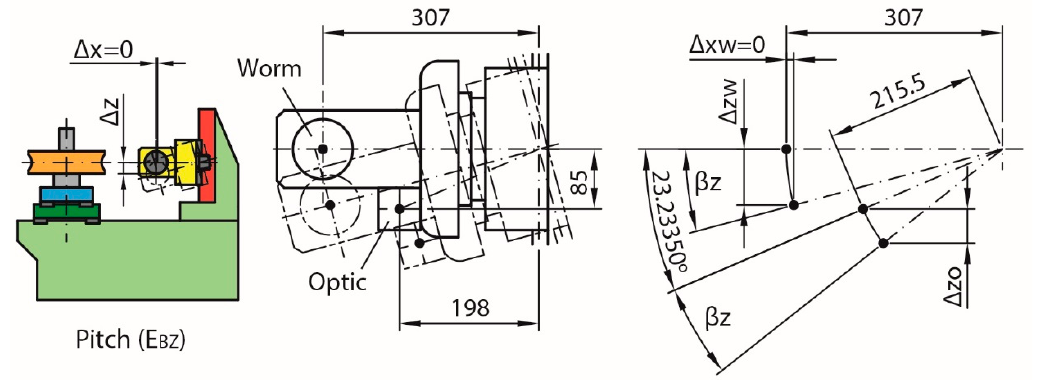
12 of 17 Figure 10. Linear encoder (Z-axis) numerical compensation (height position): errors, optic location and results. 3.2.2. Non-Compensated Errors Evaluation We used the same positions along the Z-axis as in the numerical compensation to evaluate the errors not compensated by the linear encoder. It has also been considered that the rotation axes of the pitch E BZ and roll E CZ errors are on the mid-plane of the linear guides of the vertical carriage movement. The imperfections in the guides can generate errors, which, although not detected by the measuring instruments and, therefore, not compensated, significantly influence the rolling tests results. The pitch error E BZ was only partially compensated in the calculation of the position error E ZZ due to the location of the optic. The total displacement of the worm in the Z direction ( Δ z w ) is greater than that obtained by the laser interferometer reading ( Δ z o ) because the distance of the optic’s position from the nominal rotation point is smaller (Figure 11). As the E BZ pitch error ( β z ) is 17 arcsec in the evaluated area (Figure 12), only 16.3 μ m out of the potential 25.3 μ m height error has been